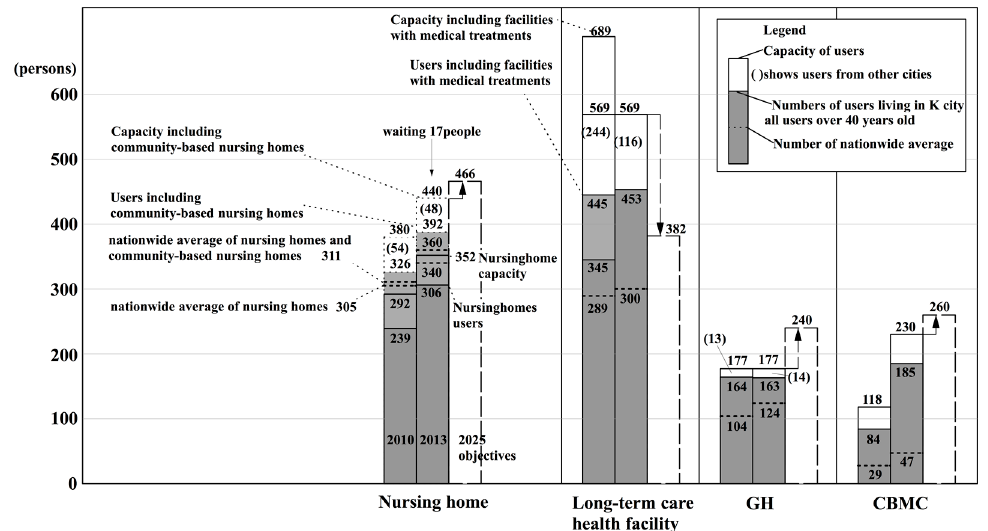
Figure 8. Actual situation regarding the capacity and the number of users for each type of facility in K city.